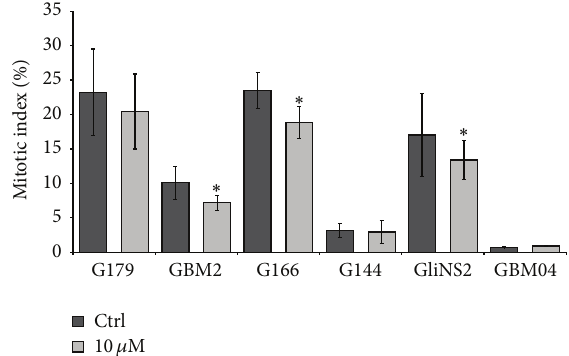
Figure 3: Pio effect on GSC proliferation. Cell proliferation was evaluated through the determination of the mitotic index. Results are reported as percentages resulting from means of two indepen- dent experiments ± SEM. Yates’ Chi-square test on raw data: ∗ 𝑝 < 0 , 05